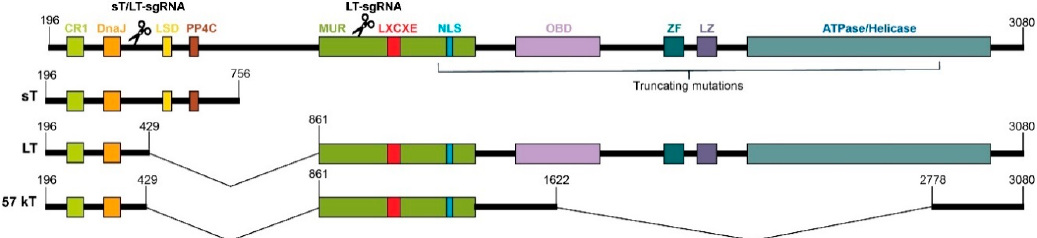
Figure 1. Schematic representation of functional domains of Merkel cell polyomavirus (MCPyV) tumor antigens (TAs). The small, large and 57 kDa tumor antigens (sT, LT, and 57 kT, respectively)